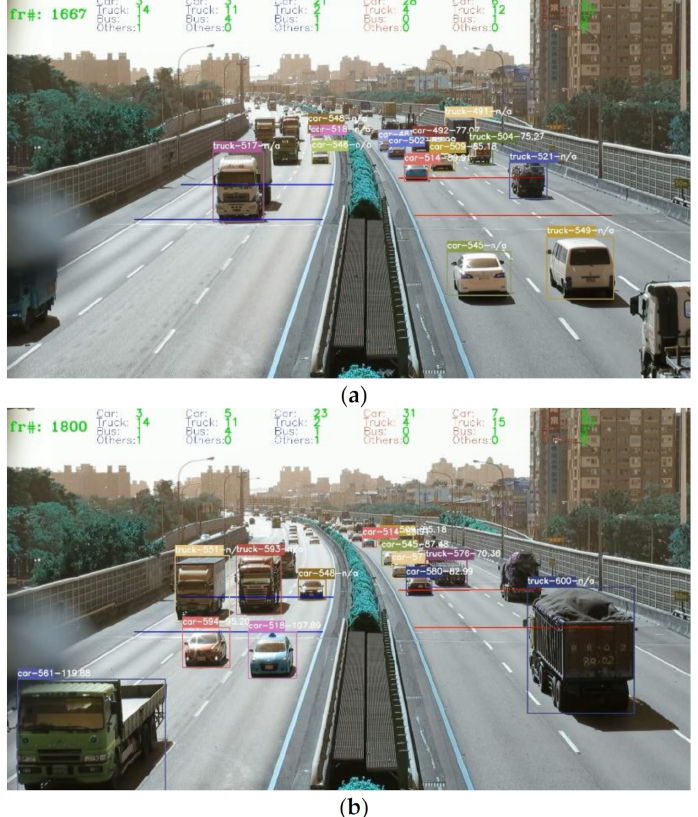
Figure 10. Velocity estimation in the video taken on National Freeway No.1 ( a , b ).